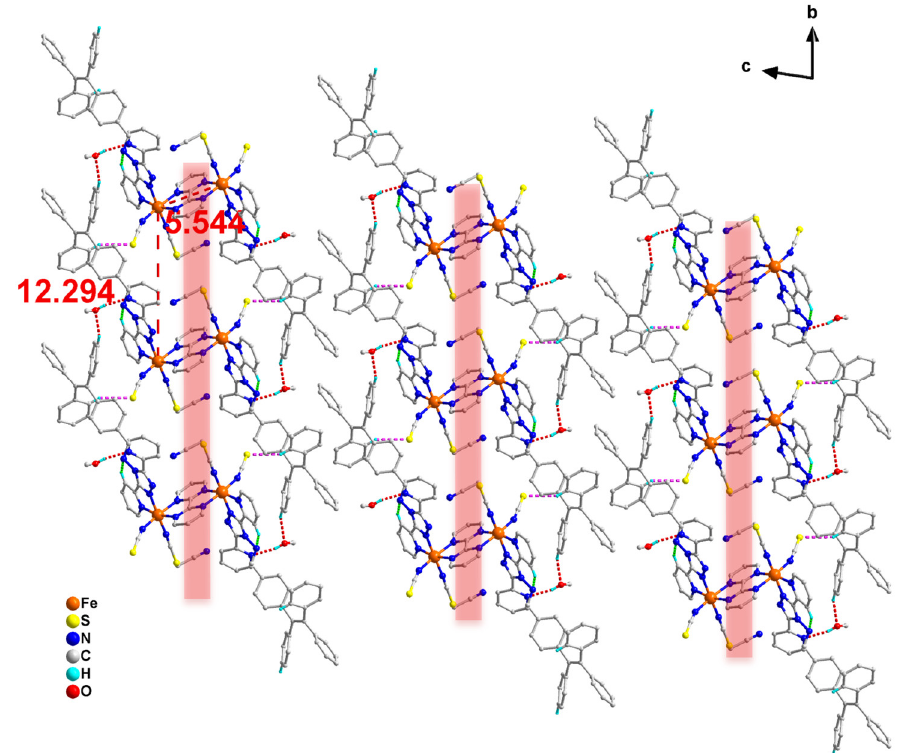
Figure 4. Schematic showing the crystal packing, lattice solvent distribution, and hydrogen bonding of 1 at 100 K. The pale purple and red dashed lines represent intermolecular hydrogen bonds, and the green dashed lines represent intramolecular hydrogen bonds. The numbers in the figure are distances in Å.